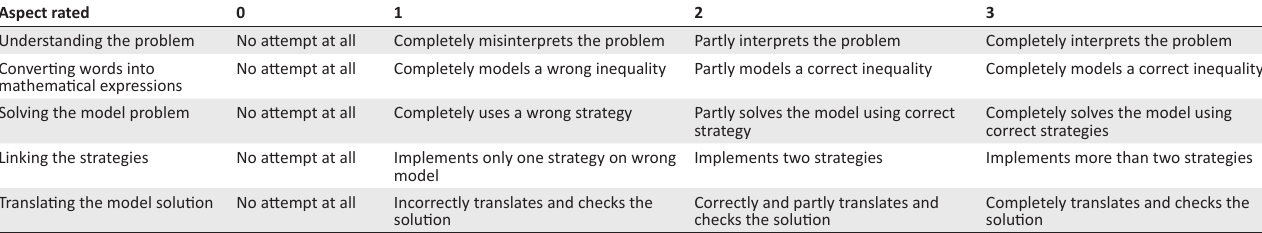
TABLE 1: Rubric for quadratic inequality problem solving test. Aspect rated 0